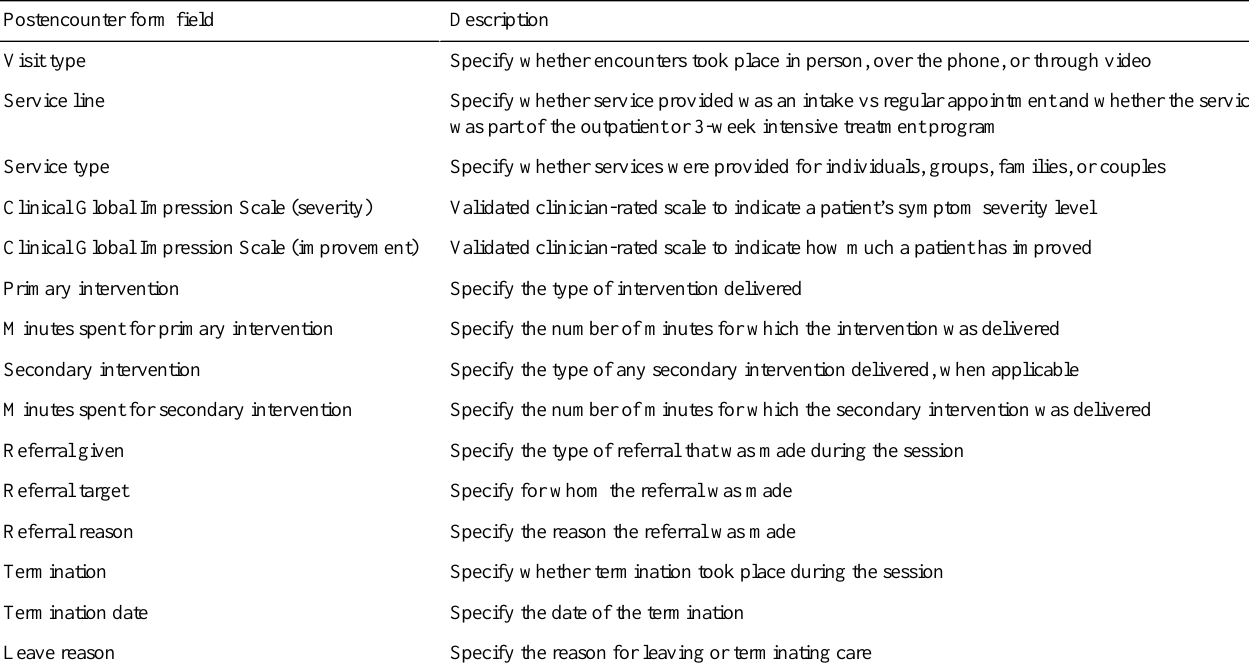
Table 1. Road Home Program postencounter form fields with descriptions DescriptionPostencounter form field